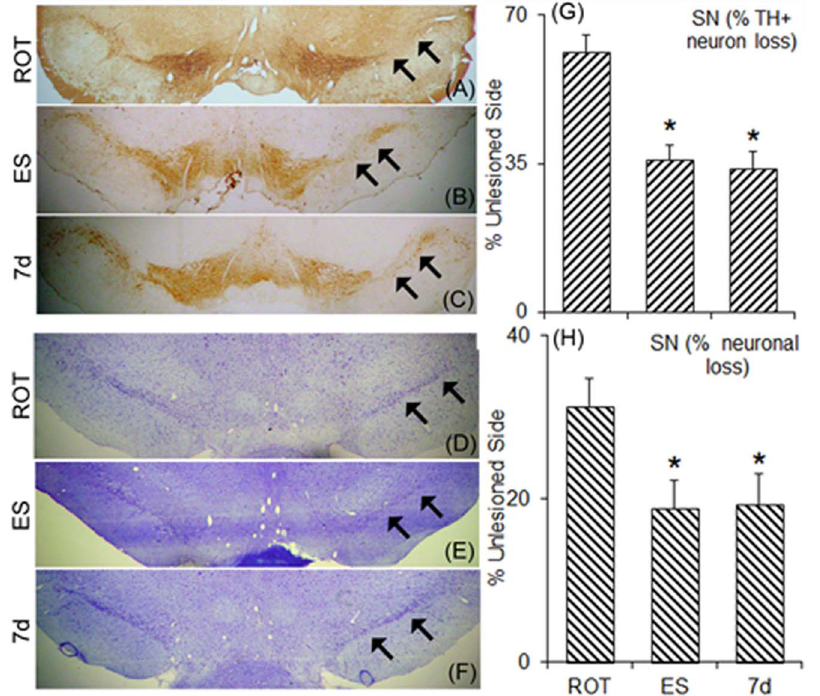
Figure 13. Protein levels of GDNF in the striatum and in the substantia nigra (SN). The ipsilateral striata and SN were dissected out sham grafts (ROT) and 7 days differentiated cells transplanted animals, and immunoblot images from four different animals are provided (A). A ratiometric analysis of the GDNF band intensity to b -actin, followed by fold changes with respect to rotenone is plotted (B). There was approximately 3-fold increase in both the regions, striata and SN as compared to rotenone treated control. Results are represented as Mean 6 SEM, * p # 0.05 as compared to the control group, n=4–6.